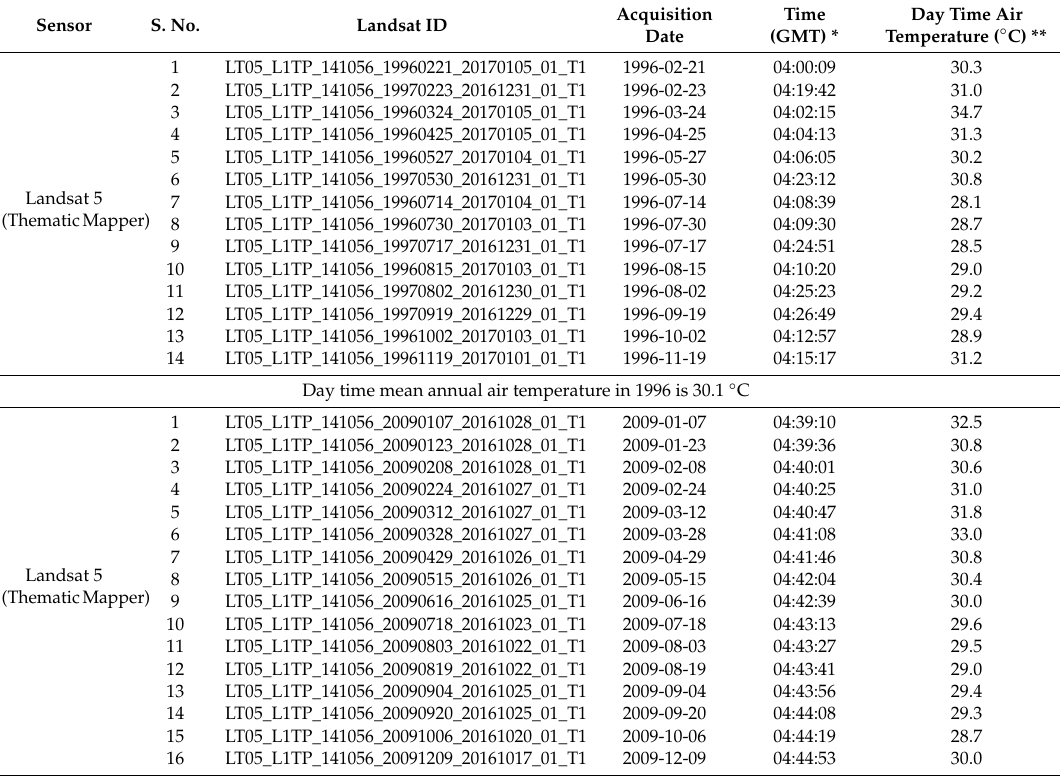
Table A2. Properties of the Landsat images (Level 2) used in this